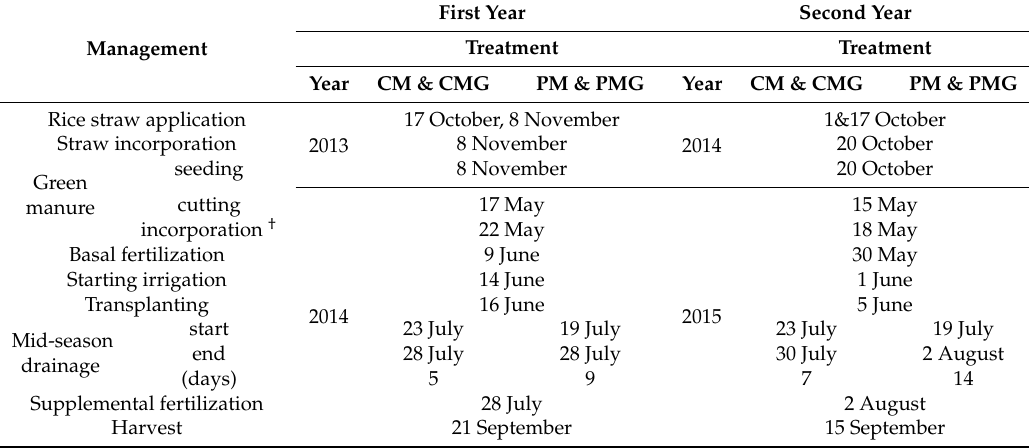
Table 1. Field management